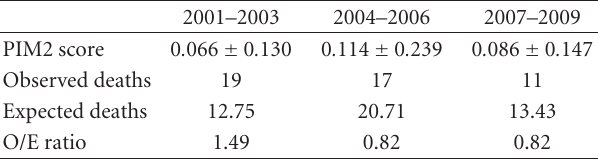
Table 2: PIM2 score and observed